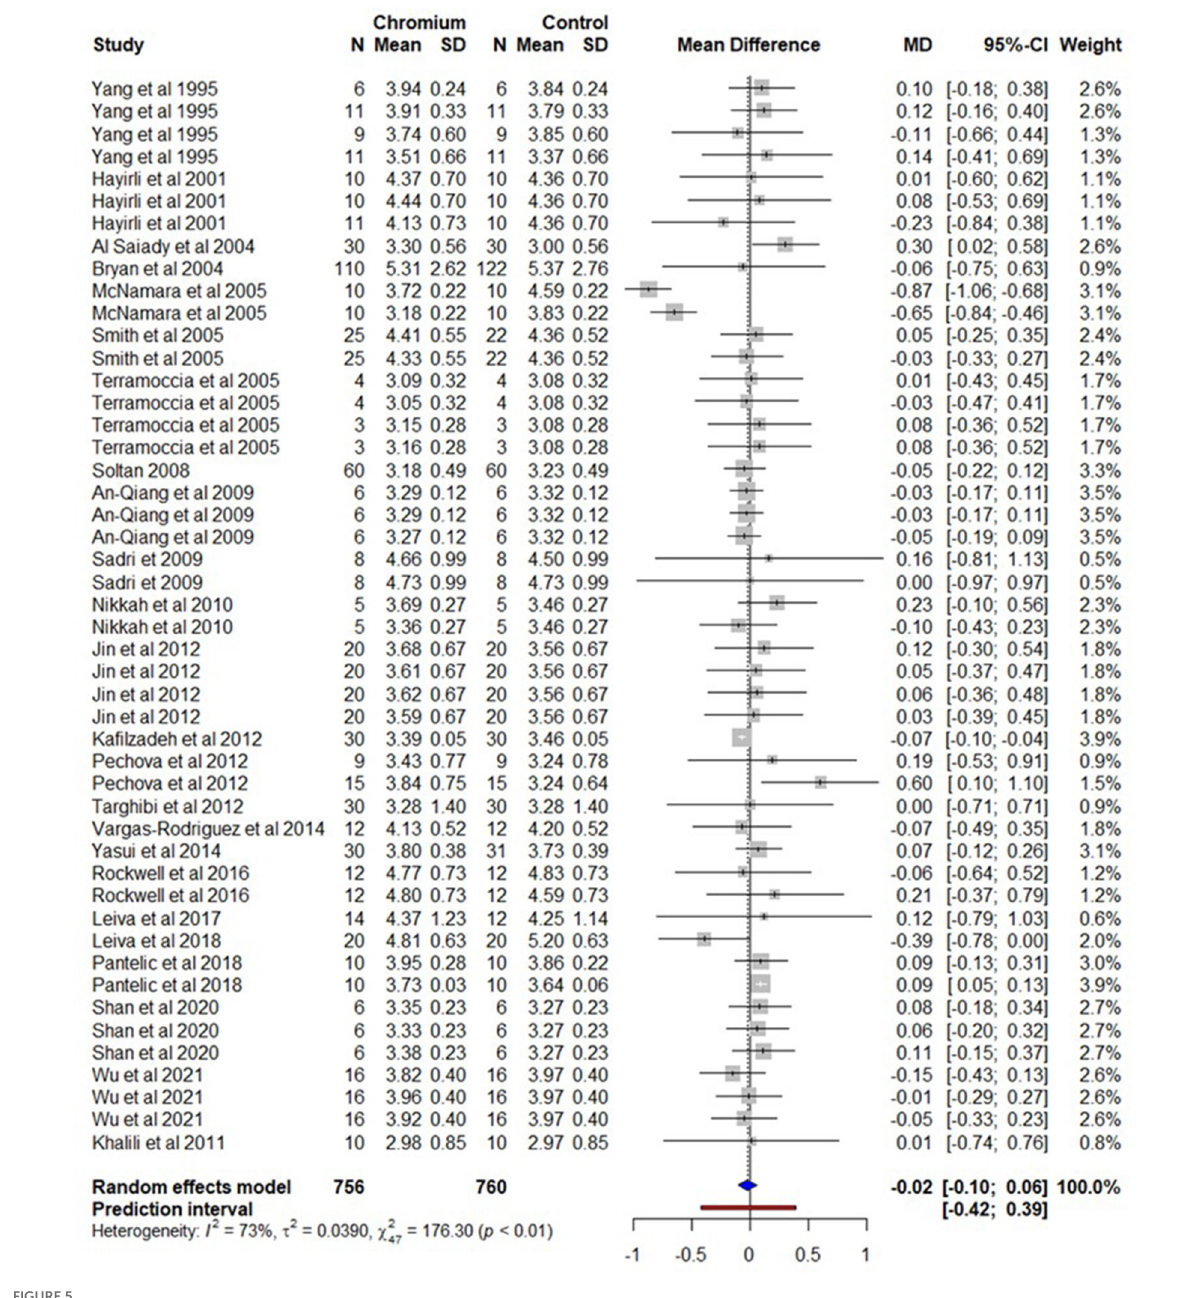
FIGURE5 The forest plot of the random-effect meta-analysis for milk fat content. The effect size was calculated as the mean difference (MD), and the solid vertical line represents the line of no effect or zero line. The dotted vertical line represents the average effect size for milk fat content in cows supplemented with chromium. The negative value under the MD heading indicates a decrease in milk fat content and vice versa. The black horizontal line represents the confidence interval for each study and the gray square represents weight or effect size of the corresponding study. The blue diamond represents the average effect size of the